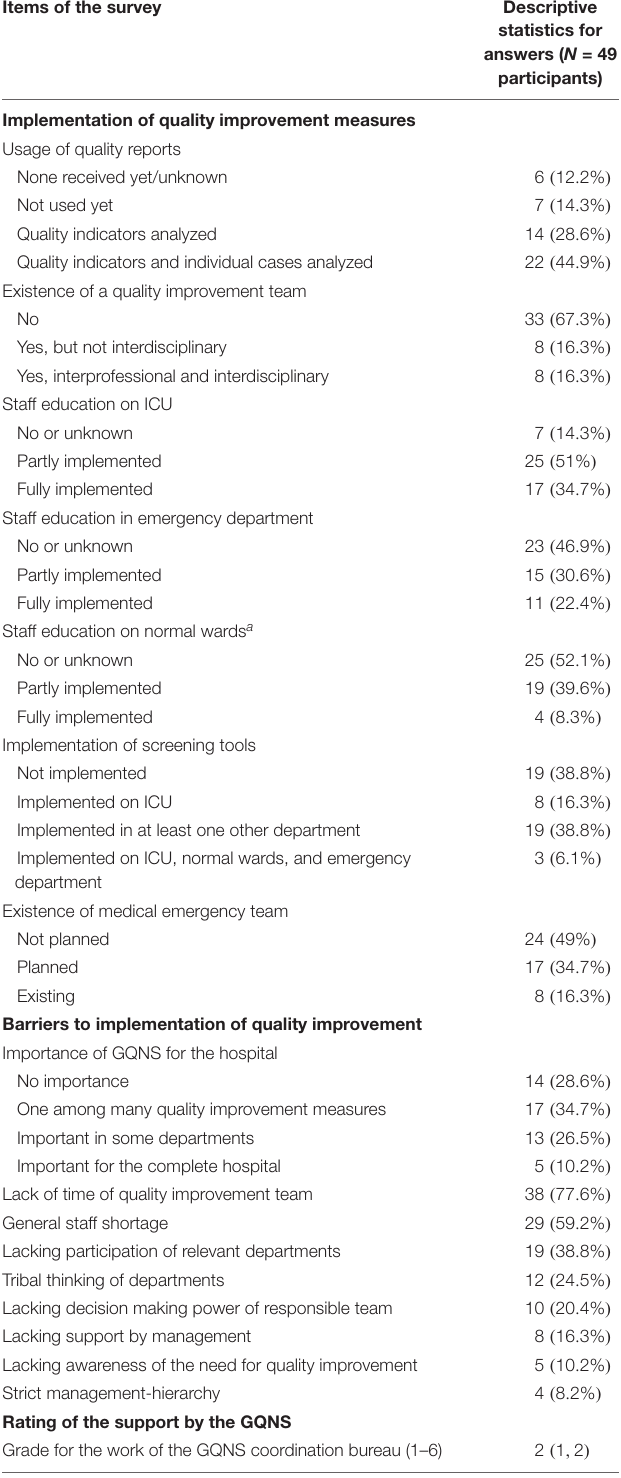
TABLE 4 | Results of survey of the local quality improvement leaders of participating hospitals. Items of the survey Descriptive